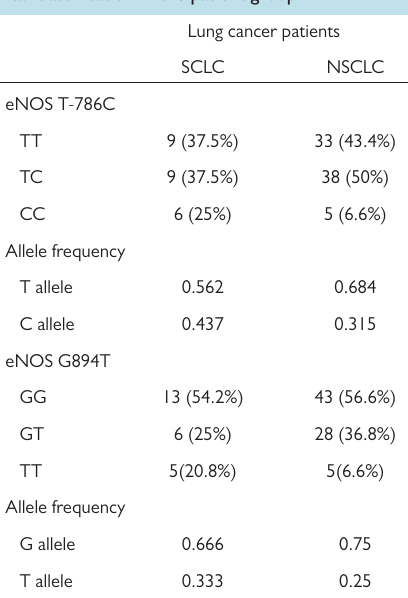
Table 6. Distribution of eNOS T-786C and eNOS G894T polymorphisms according to histopatholog- ical classification in the patient group